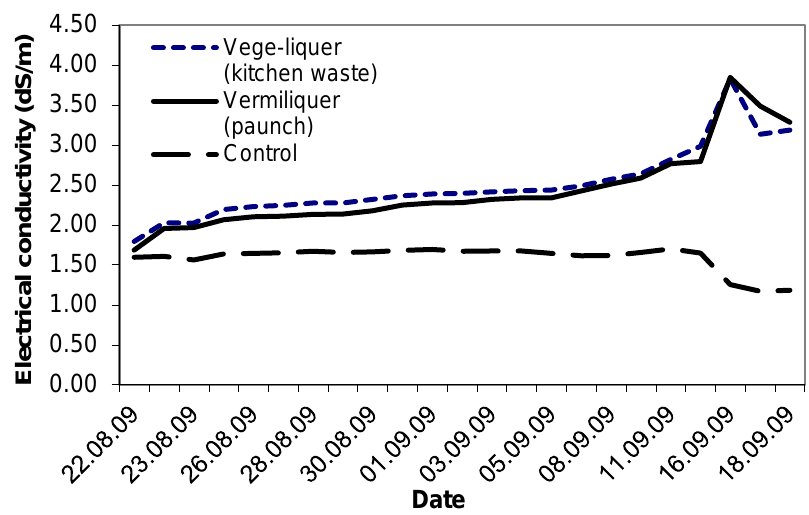
Figure 6. Trend in EC (mS/m) over time in the control, vermiliquer and vege-liquer solutions in Study VI, transplanted 22 August 2009.